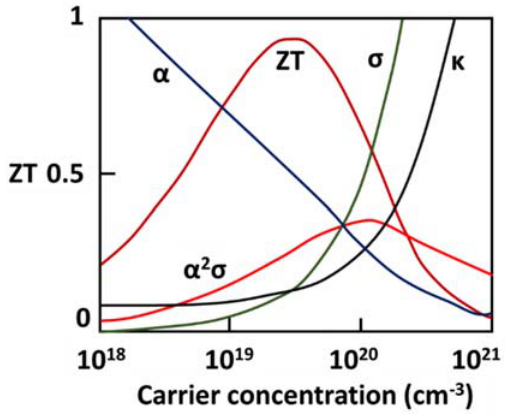
circuit resulting in electric current; ( c ) Mechanism of thermoelectric refrigeration. External current makes charge carriers to carry heat from cold-side to hot-side; ( d ) Key components of a thermoelectric generator (TEG) module [31].